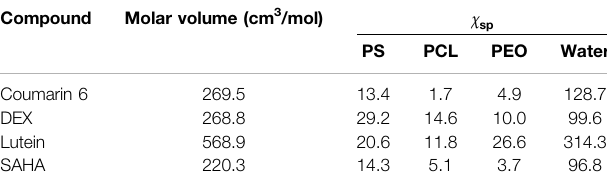
TABLE 3 | Flory – Huggins interaction parameter ( χ sp ) of drugs-polymer and drug- water.